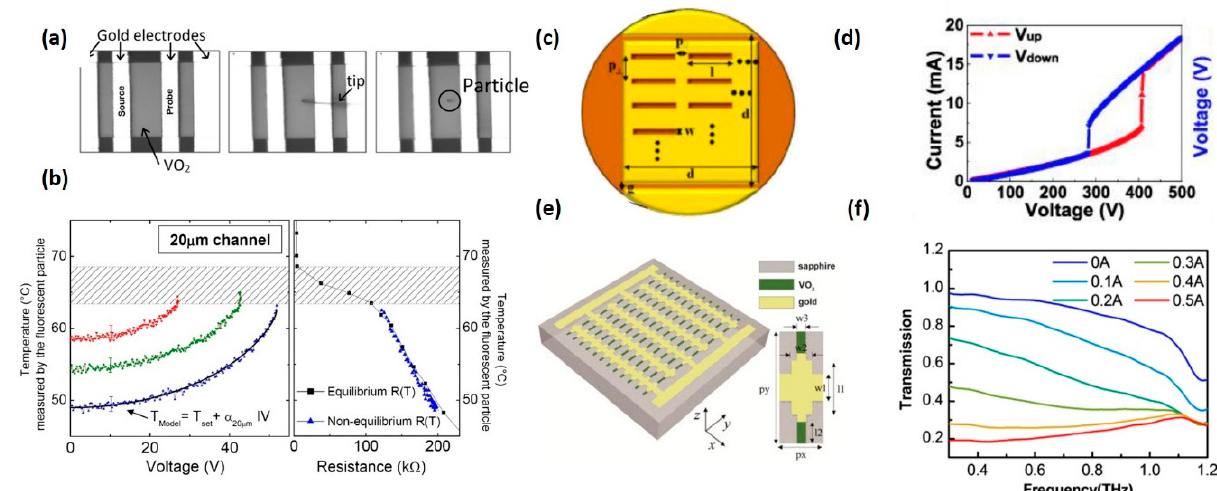
Figure 7. Electrical field-excited IMT in VO 2 thin film. ( a ) 20 um channel before, during, and after positioning the micron- wide rare-earth fluorescent particle sensor. The temperature of the particle is measured through fluorescence spectroscopy. ( b ) Local temperature versus DC voltage ( left ) and local temperature versus resistance ( right ) in voltage-induced IMT (blue triangle) and thermal equilibrium IMT (black square). Reproduced from [61], with permission from American Physical Society 2013. ( c ) Schematic of the nanoantenna array deposited on VO 2 film with 1 mm-wide parallel electrodes. ( d ) External voltage-driven insulator–metal transition in VO 2 thin film. The voltage is increased at a rate of 1 V/s. Reproduced from [122], with permission from Optical Society of America 2011. ( e ) The schematic structure and a unit cell of the low bias controlled VO 2 hybrid metasurface. The device consists of metal bias lines arranged with grid-structure-patterned VO 2 film on sapphire substrate. ( f ) Magnitude transmission with different electrical biases under a constant heating temperature of 68 °C. Reproduced from [62], with permission from Optical Society of America 2017.